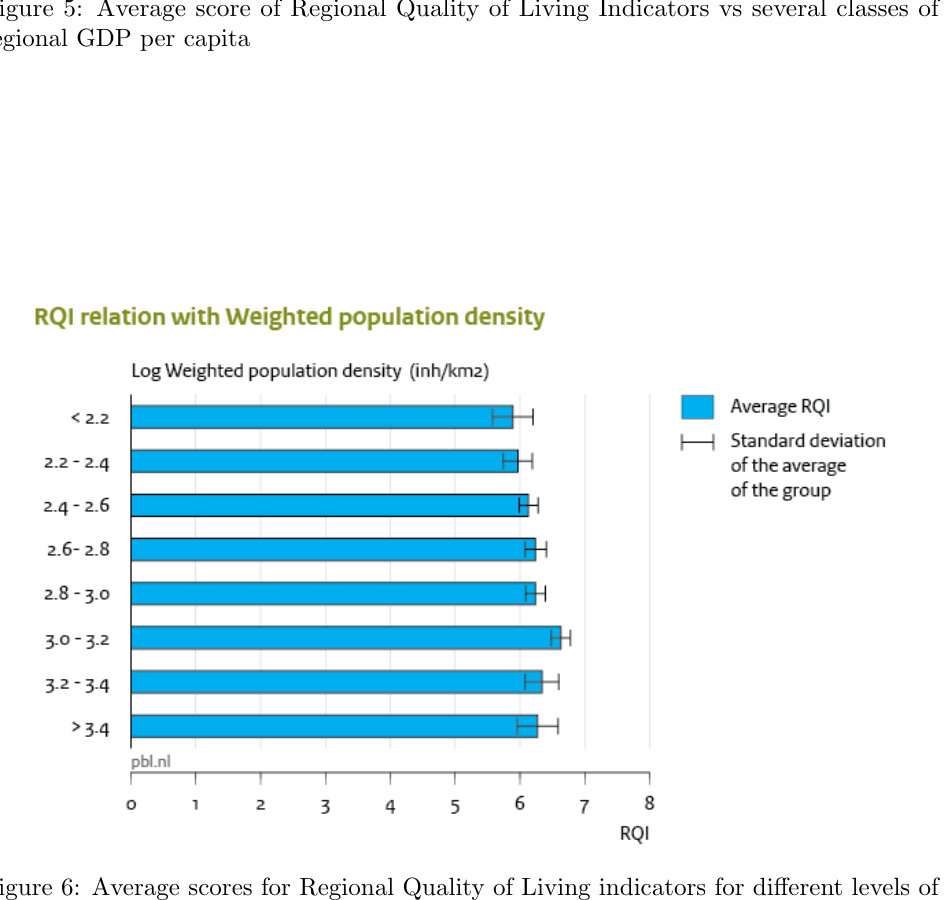
REGION : Volume 2, Number 2,